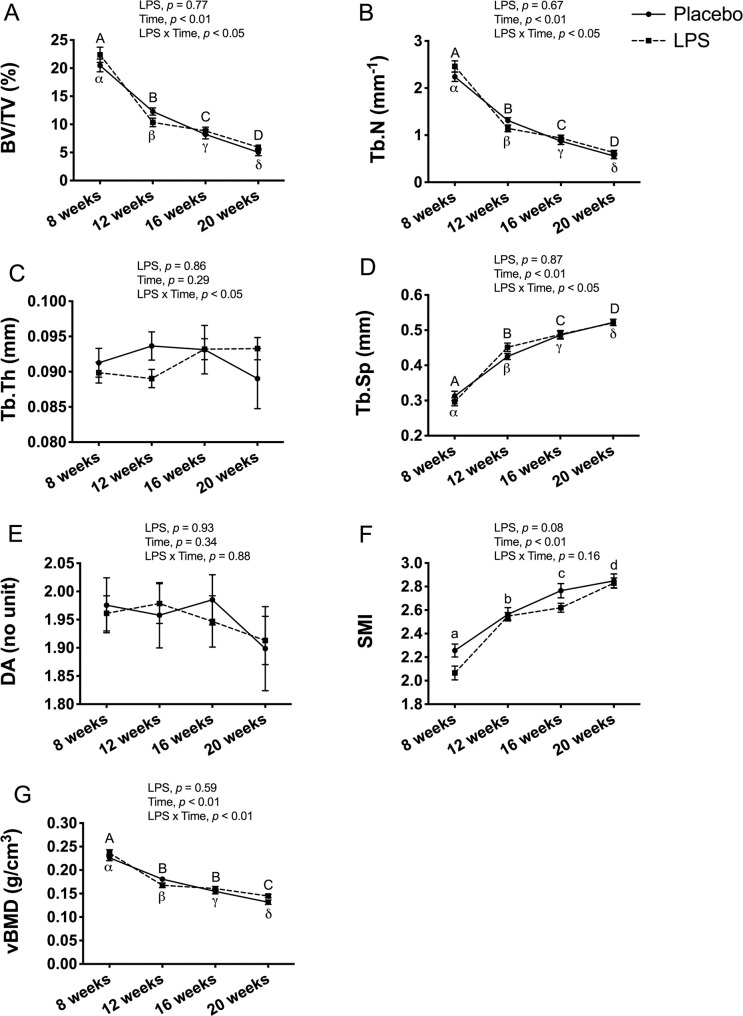
Female trabecular bone structure and volumetric bone mineral density (vBMD) at proximal tibia metaphysis.Trabecular bone structure and vBMD were unaltered with 12-weeks of lipopolysaccharide (LPS) treatment between the placebo (n = 11) and LPS group (n = 27). (A) Bone volume fraction (BV/TV) (B) Trabecular number (Tb.N) (C) Trabecular thickness (Tb.Th) (D) Trabecular separation (Tb.Sp) (E) Degree of anisotropy (DA) (F) Structural model index (SMI) (G) Trabecular vBMD (g/cm3). Data represented as mean±SEM. Significant differences between timepoints (main effect for time) are denoted with lowercase letters; Significant differences between timepoints within a group (interaction effect) are denoted with Greek letters for placebo group and uppercase letters for LPS group.